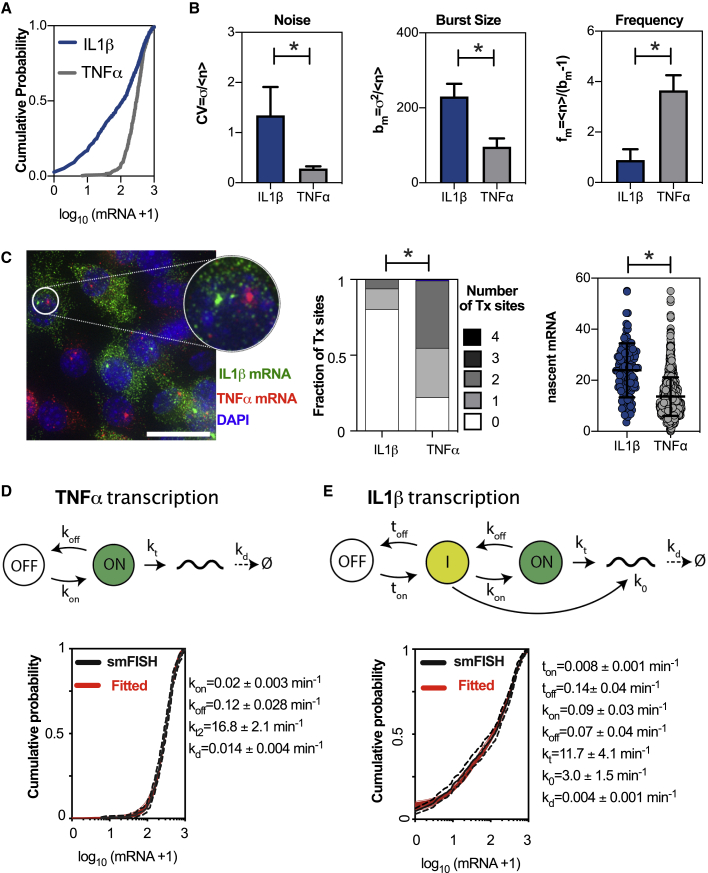
Mathematical Modeling Reveals Differential Control of TNF-α and IL-1β Transcription(A) Differential expression of IL-1β and TNF-α mRNA. Shown is the cumulative distribution function of mRNA counts in RAW 264.7 macrophages stimulated with 500 ng/mL of lipid A for 3 h. A total of 718 cells were measured for IL1β, and 356 for TNF-α, and pooled across at least three smFISH experiments, respectively, and expressed as log10(mRNA+1).(B) Characteristics of single-cell mRNA expression. Shown is the CV, burst size (bm), and frequency (fm) calculated based on moments of the mRNA count data from (A) (expressed as mean ± SD from experimental replicates). “∗” denotes a result of a two-sample Mann-Whitney U test between groups (p < 0.01).(C) Distribution of transcription sites is gene dependent. (Left) de-convolved wide-field microscopy image of cells with TNF-α and IL-1β smFISH, revealing Tx through an aggregation of multiple mRNA molecules in the nucleus (insert). Scale bar represents 5 μm. (Middle) the fraction of cells with 0–4 Tx calculated from (A). “∗” denotes a result of the Fisher exact test (p < 0.05) for difference in the Tx site distributions. (Right) the number of nascent mRNA per Tx. Shown are individual Tx site data, together with the mean and SD of the pooled distribution. “∗” denotes a result of a two-sample Mann-Whitney U test between groups (p < 0.01).(D) TNF-α transcription conforms to a one-step stochastic model. The comparison between measured and fitted TNF-α mRNA distributions at 3 h after 500 ng/mL lipid A treatment. In black: a Kaplan-Meier estimator of the measured cumulative distribution functions (CDF) (with 95% confidence intervals); and in red: a family of 50 models fitted to the data. Fitted parameter values (means ± SD) listed on the right.(E) IL-1β transcription conforms to a two-step stochastic model. The comparison between measured and fitted IL-1β mRNA distributions at 3 h after 500 ng/mL lipid A treatment for the depicted model. In black: Kaplan-Meier estimator of measured CDF (with 95% confidence intervals); and in red: family of 50 models fitted to the data. Fitted parameter values (means ± SD) listed on the right.